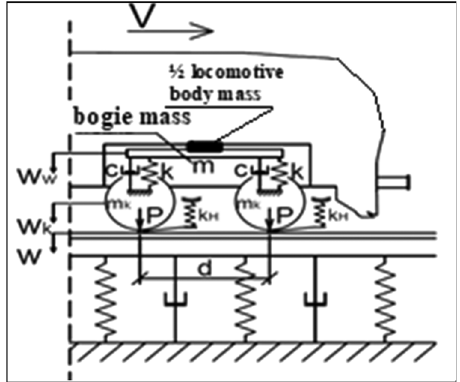
Figure 3: Vehicle - track